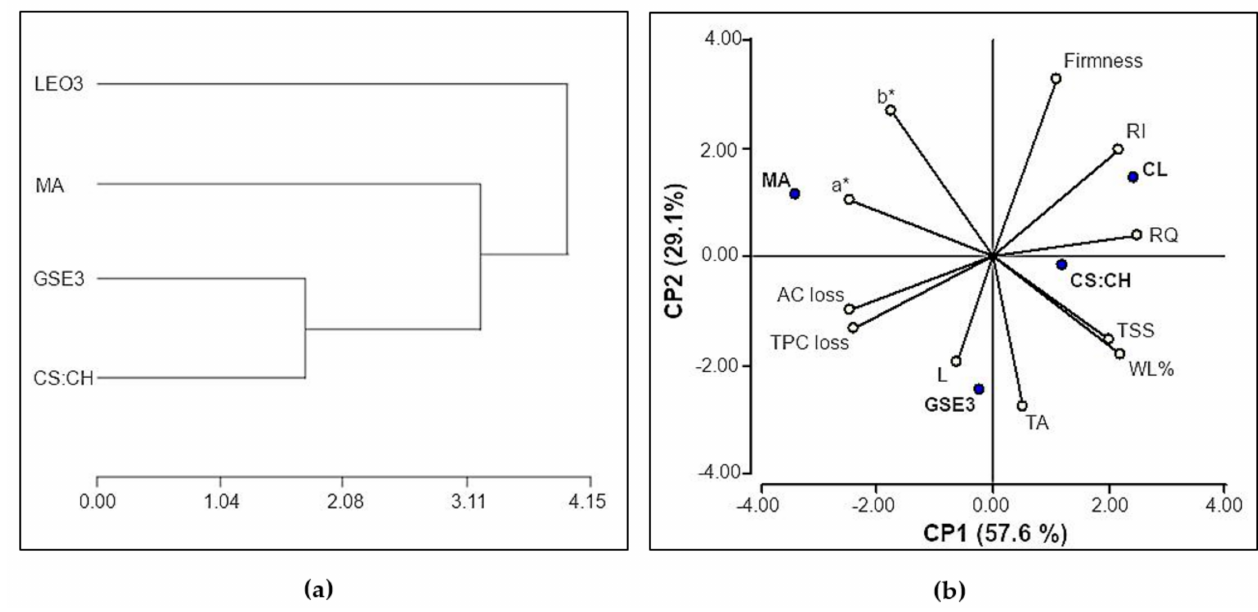
Figure 5. ( a ) Conglomerates analysis of the relevant properties of the materials used for fruit packaging. ( b ) PCA bi-plot (first and second components) of packaging materials’ samples (blue dots) regarding blueberries quality attributes (white